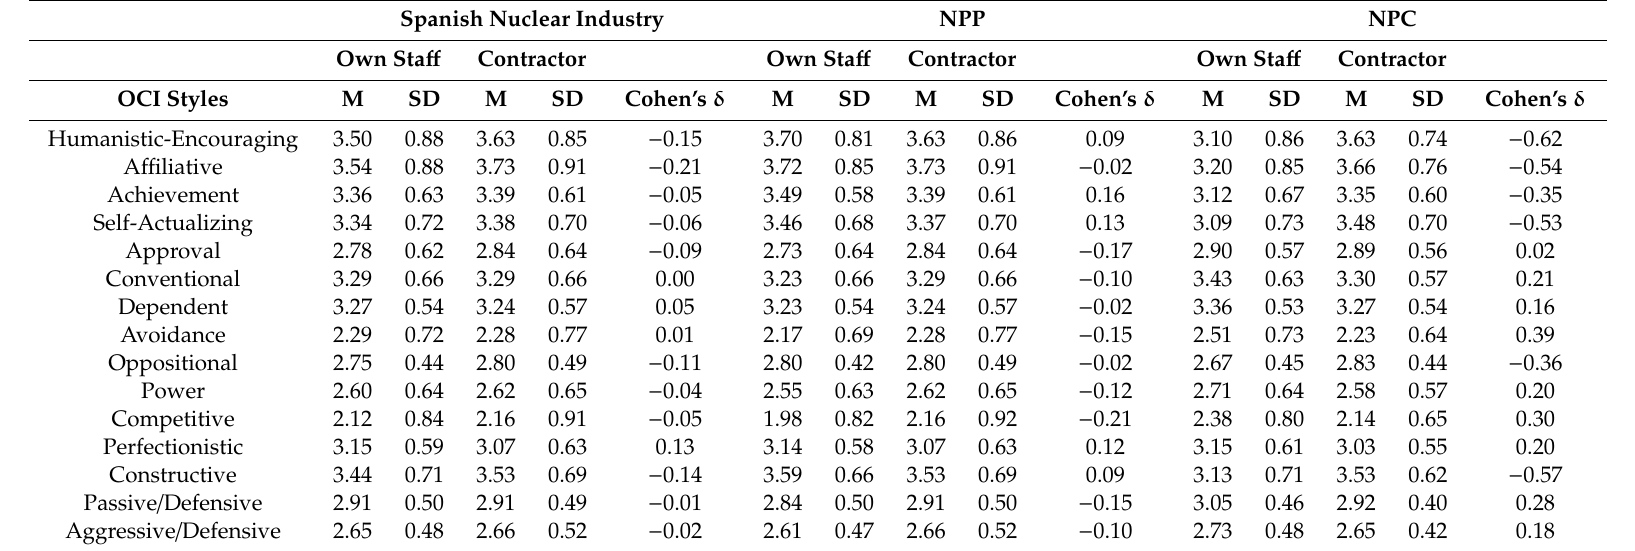
Table 8. Descriptive statistics of the OCI organizational cultures and styles by contractual